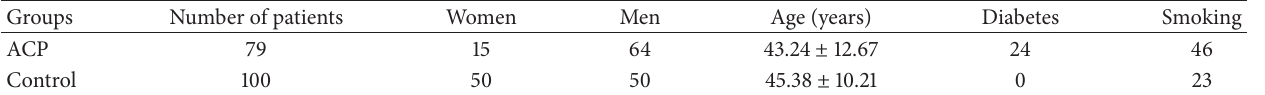
Table 2: Characteristics of groups.